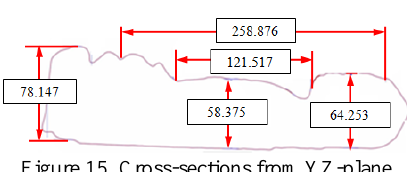
Figure 14. Cross-sections from XZ-plane